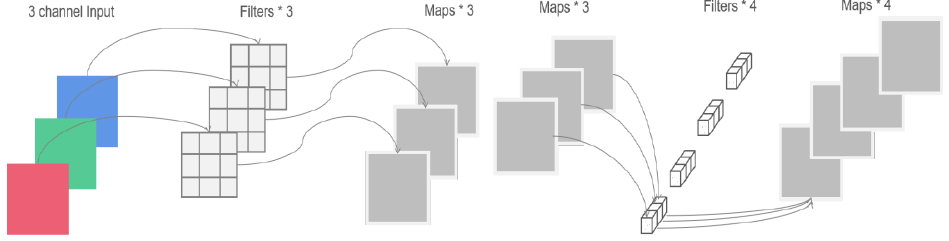
Figure 5. Framework of Depthwise Separable Convolution.